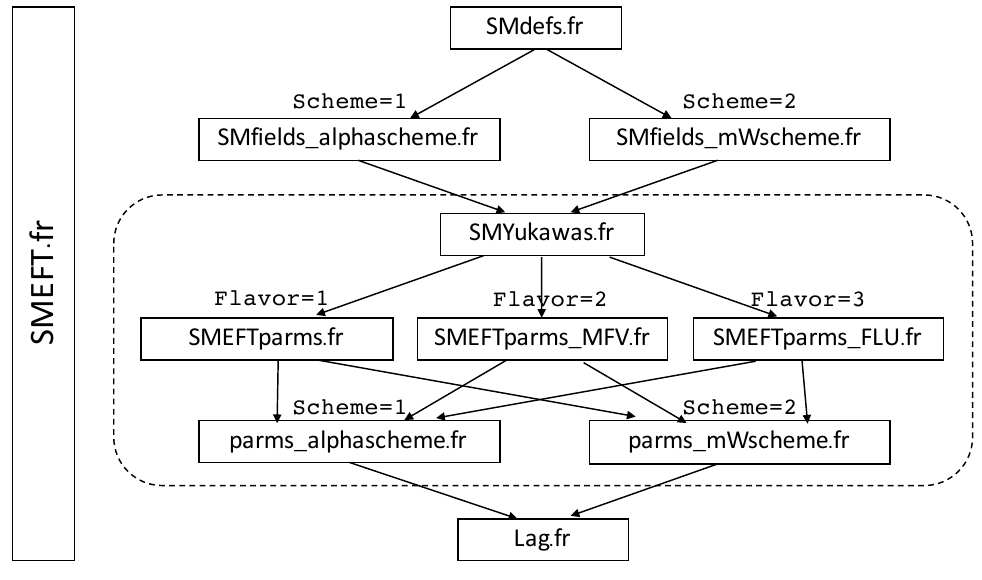
Figure 1 . Illustrative structure of the SMEFT model set B